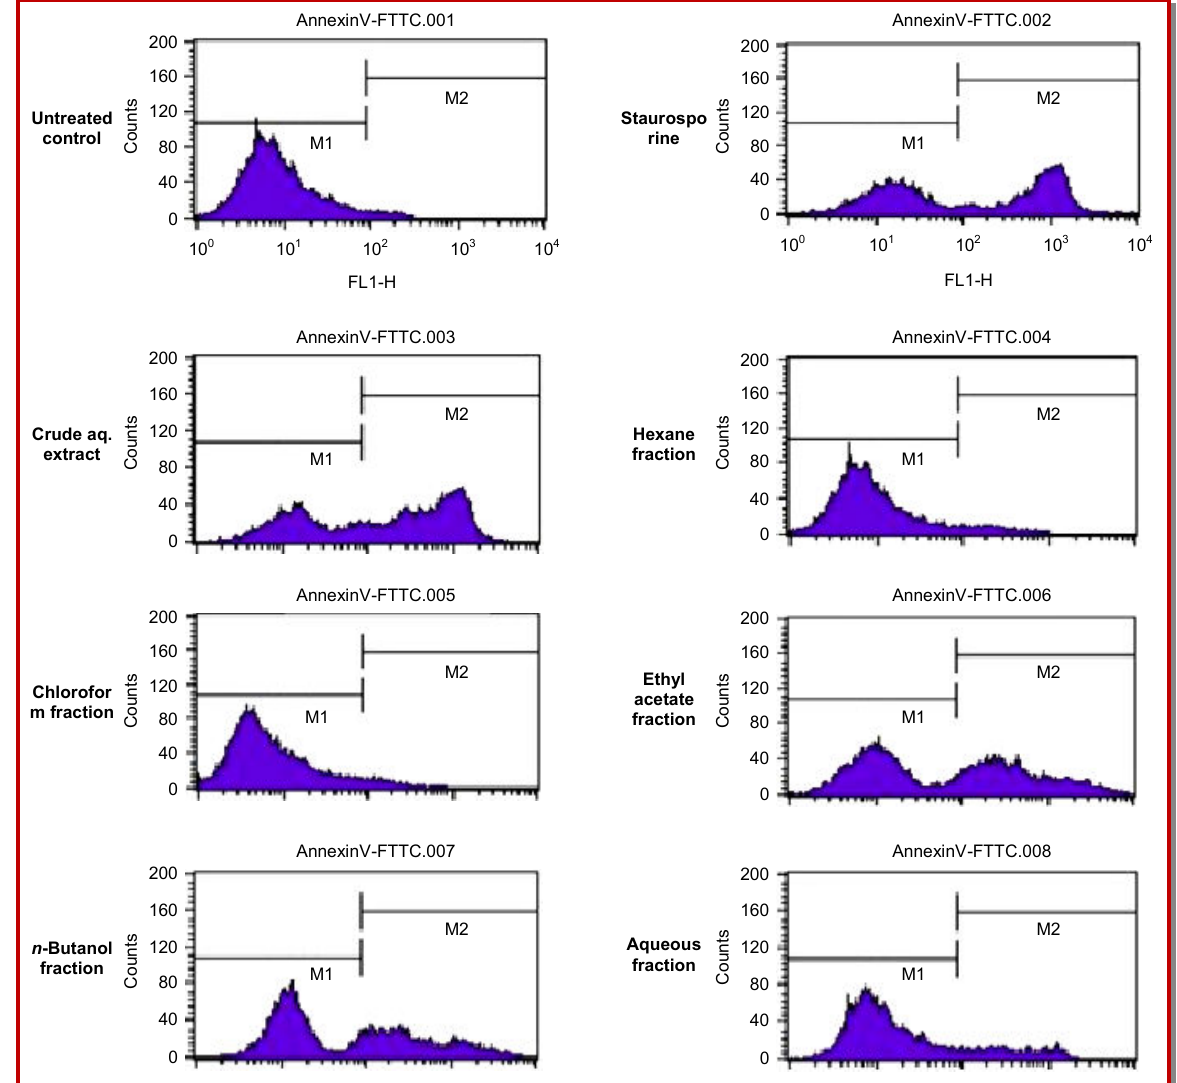
Figure 6: Annexin V-FITC binding on CHO cells treated with different organic solvent fractions, and analyzed by FACScan flow